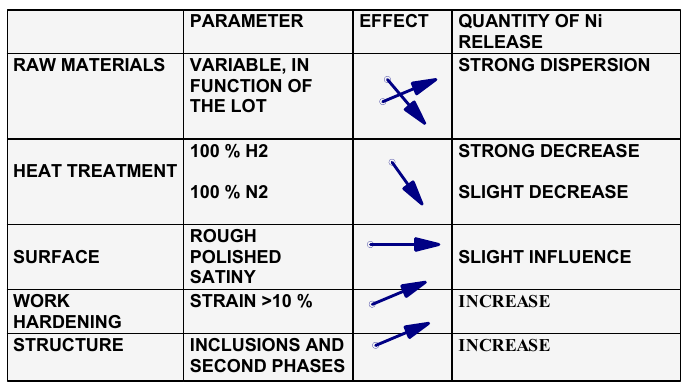
Figure 27. Factors influencing the amounts of nickel released during the manufacturing process.